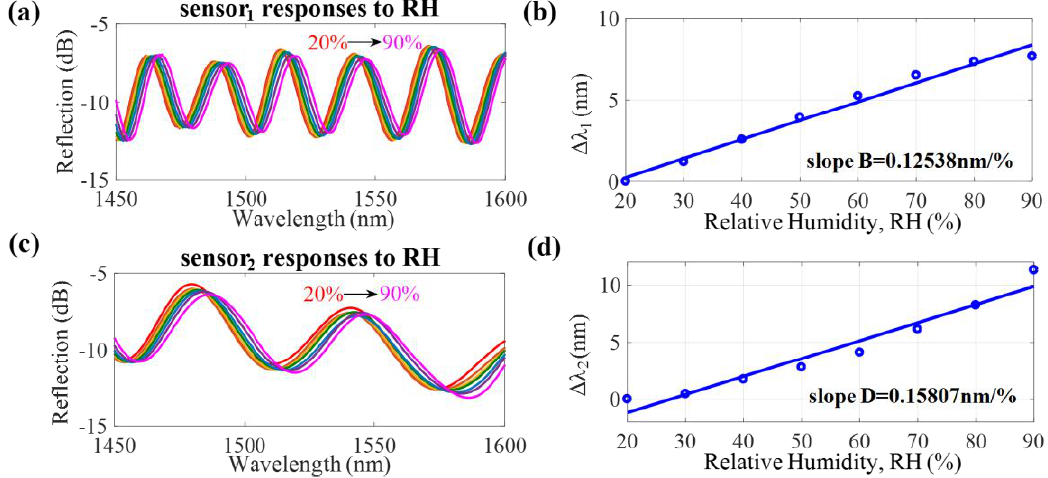
Figure 5. ( a , c ) Interference spectra of sensor 1 and sensor 2 for different RH values, respectively; ( b , d ) Corresponding RH sensitivities for sensor 1 and sensor 2 , respectively.